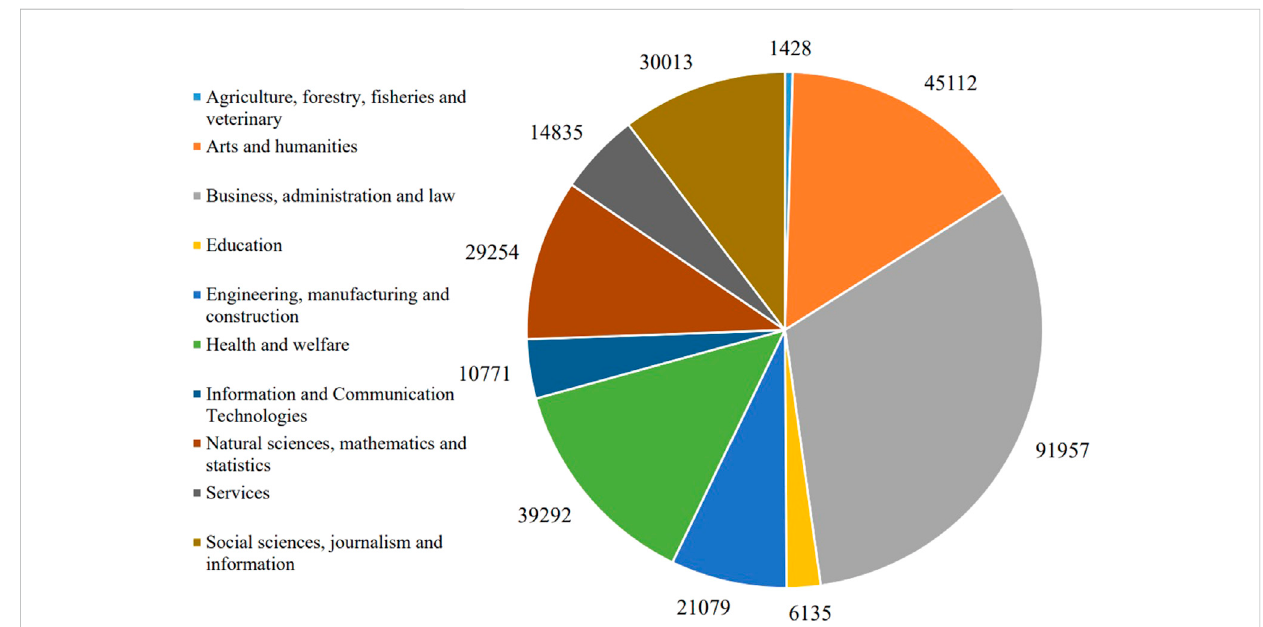
FIGURE 4 Distribution of bachelor ’ s graduates by educational fi eld, Poland, 2020. Source: own processing according to data published by Eurostat, 2022.